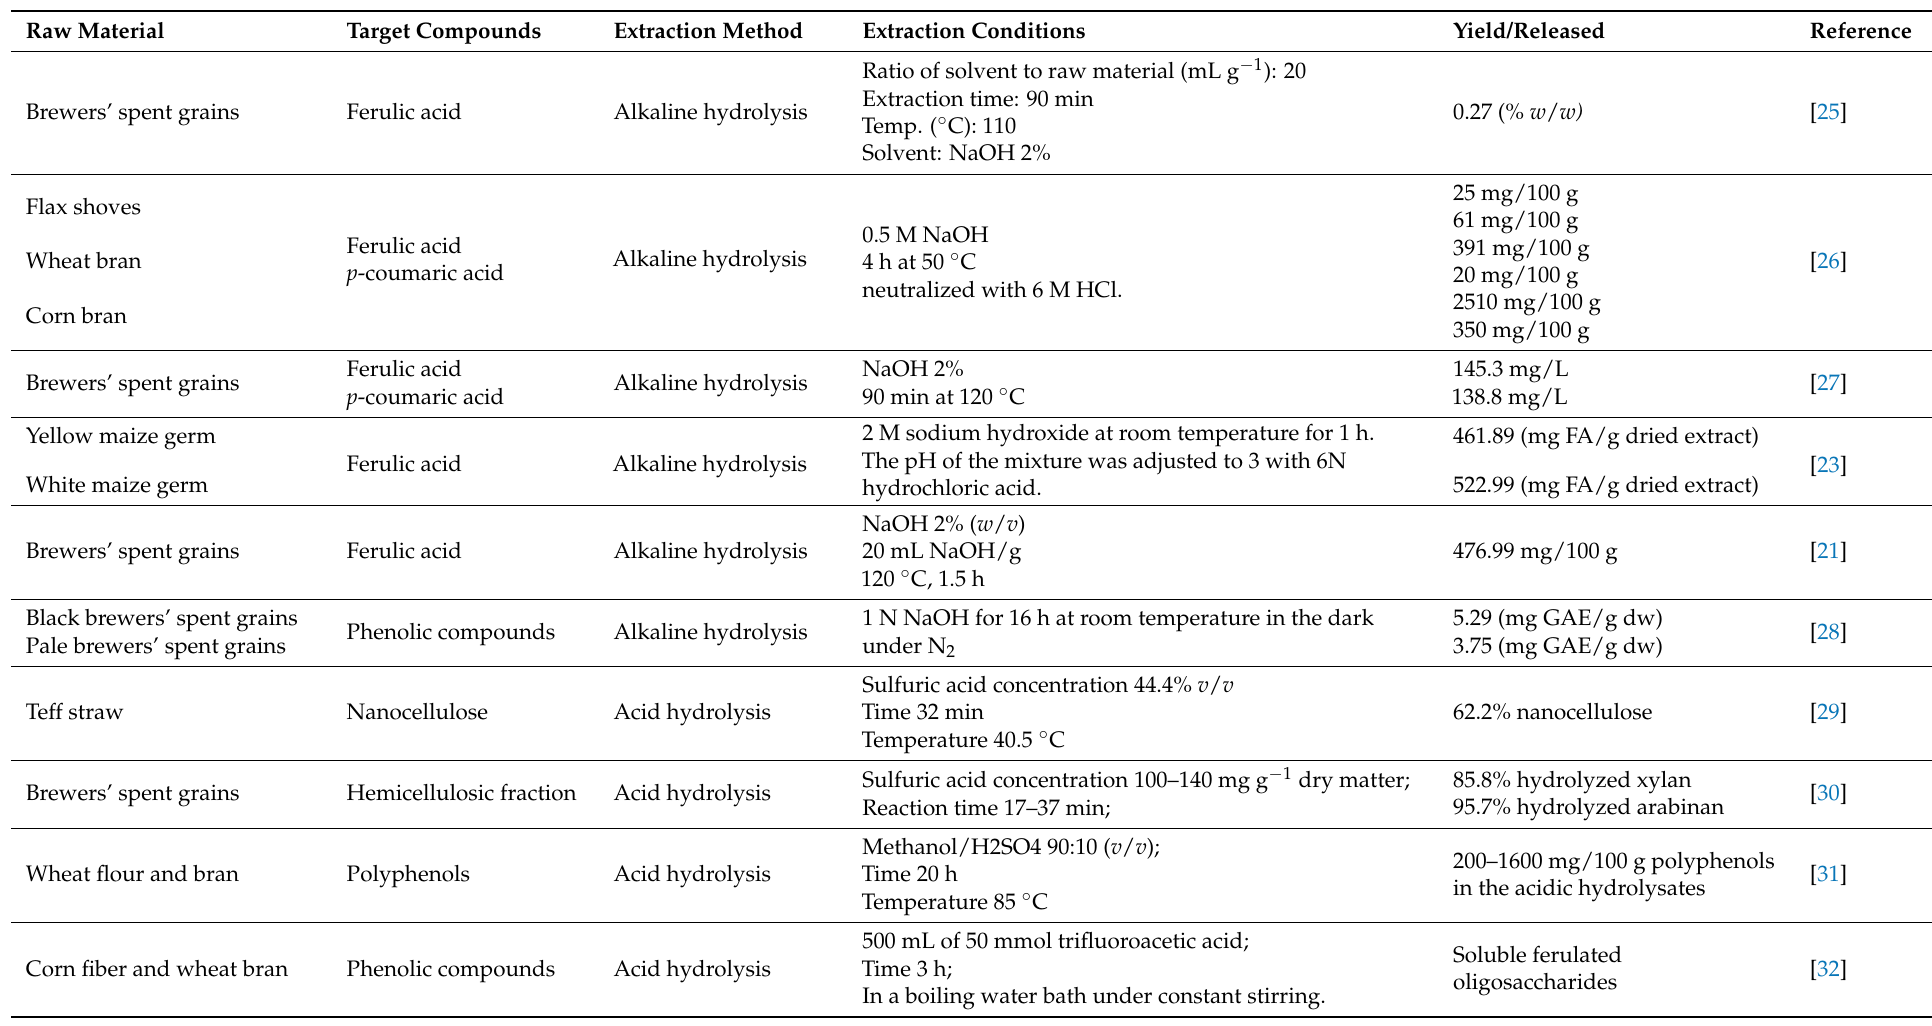
Table 1. Overview of phenolic compounds extracted by conventional extraction